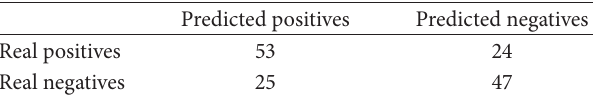
Table 3: Experimental confusion